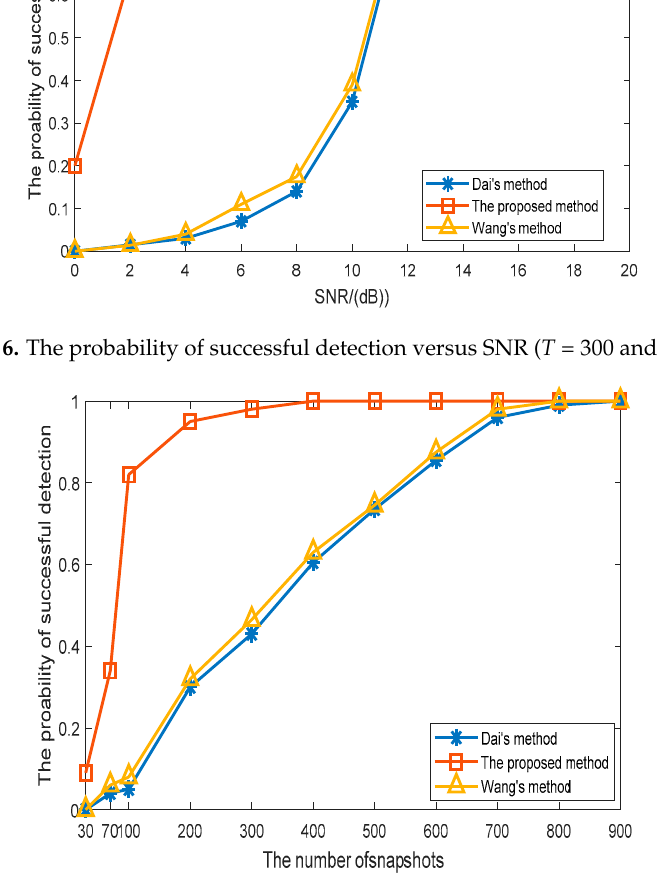
Figure 7. The probability of successful detection versus snapshots ( SNR 10 = dB and 8 M = ).